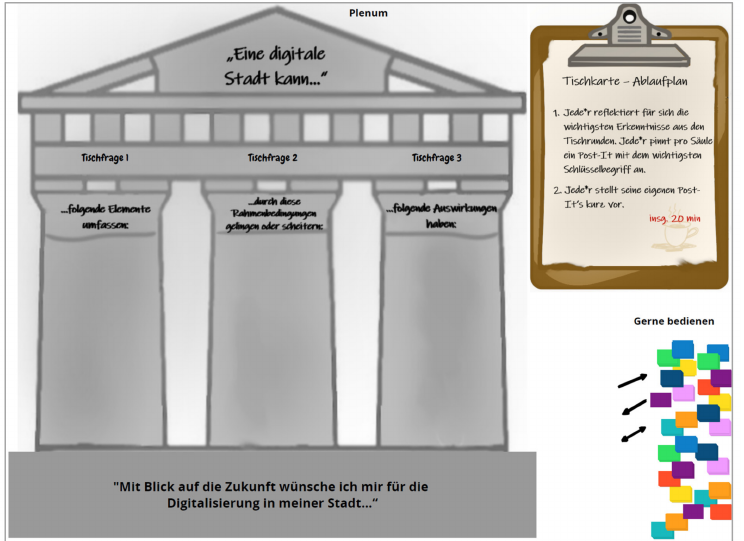
Figure 4. Conceptboard tile “definition